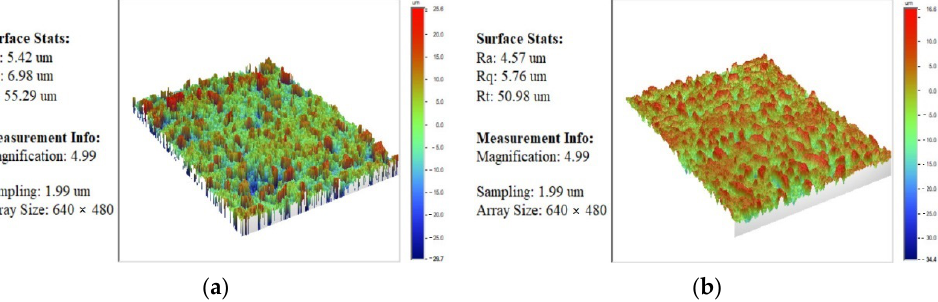
Figure 5. The measuring image of the workpiece surface roughness: ( a ) No. 11 by BWE; ( b ) No. 11 by ZCSMWE. Table 5. Experimental design and results.